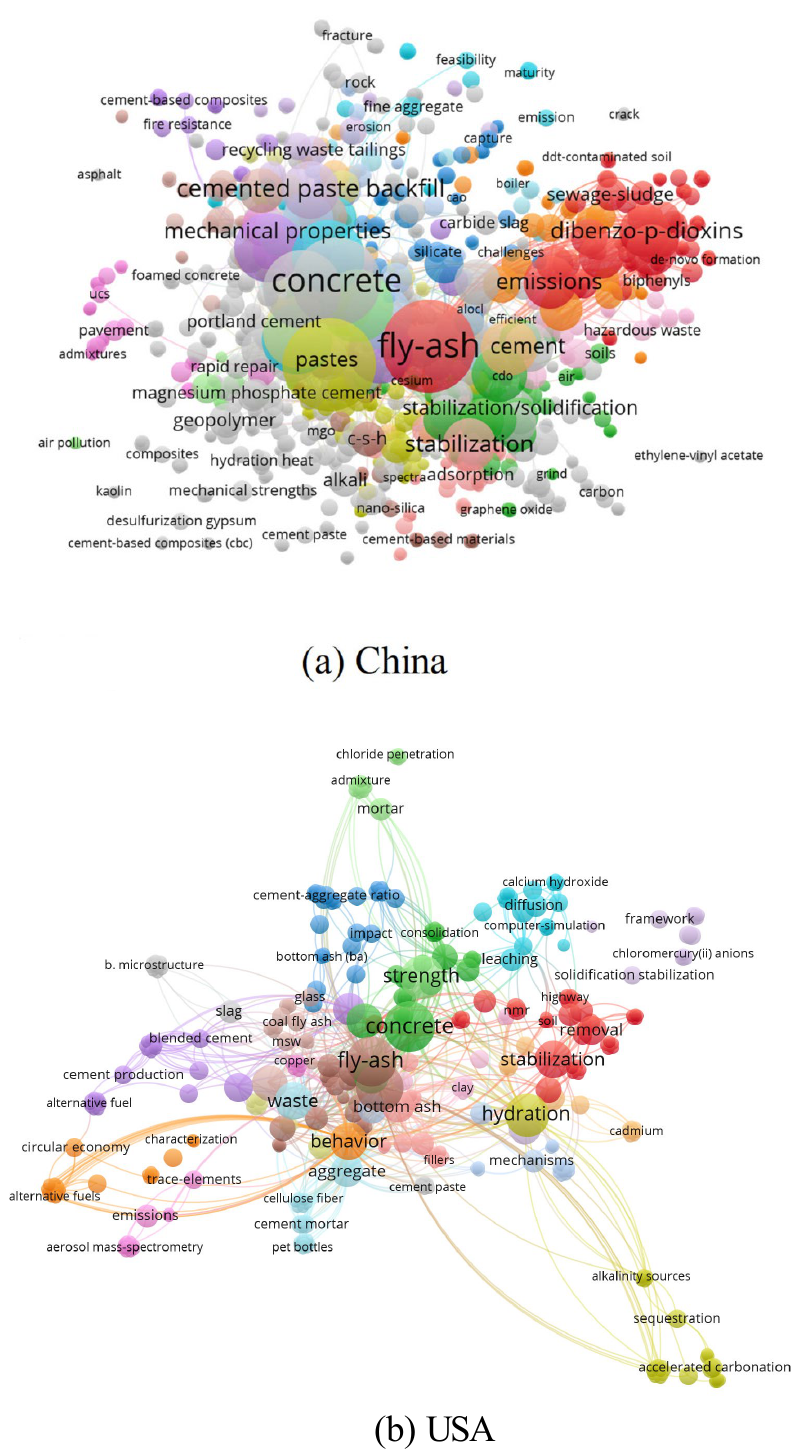
Figure 4. Keywords network visualization graphics of ( a ) China and ( b ) the USA.